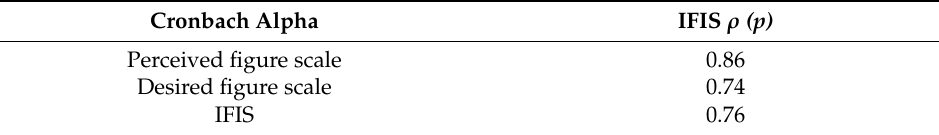
Table 3. Cronbach Alpha values for each scale of the